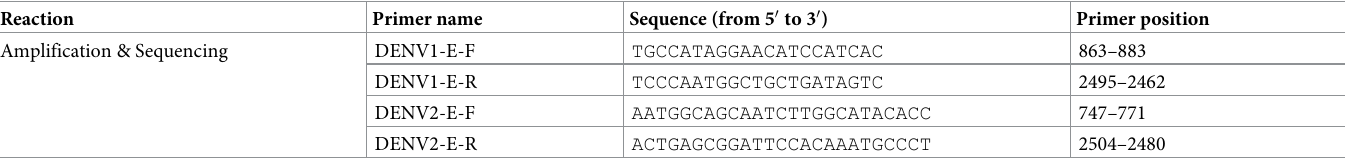
Table 2. Primers used for amplifying and sequencing the complete DENV-1and DENV-2 envelope gene.